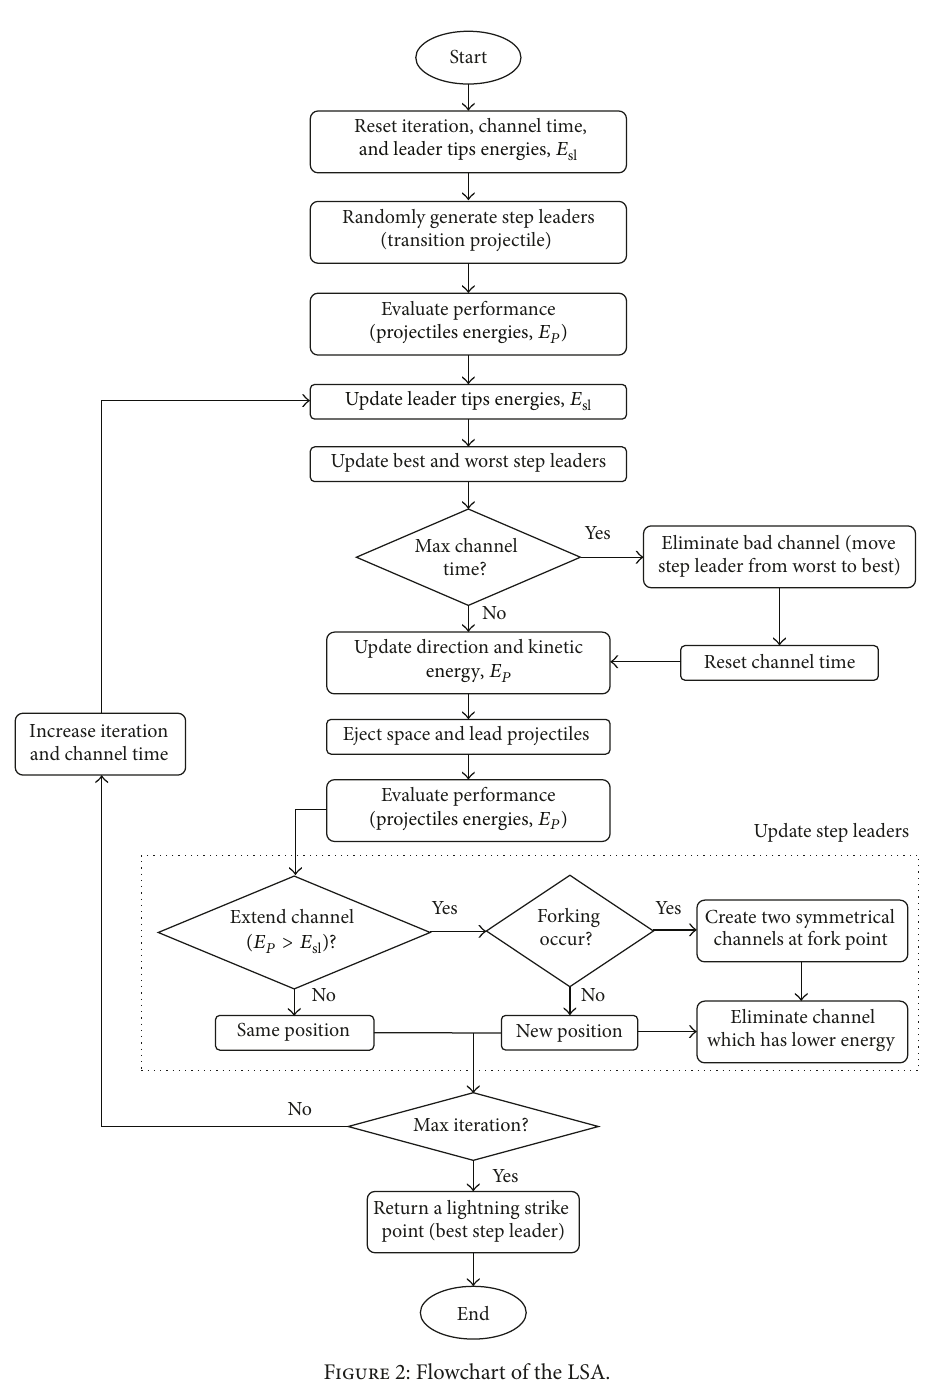
Figure 2: Flowchart of the